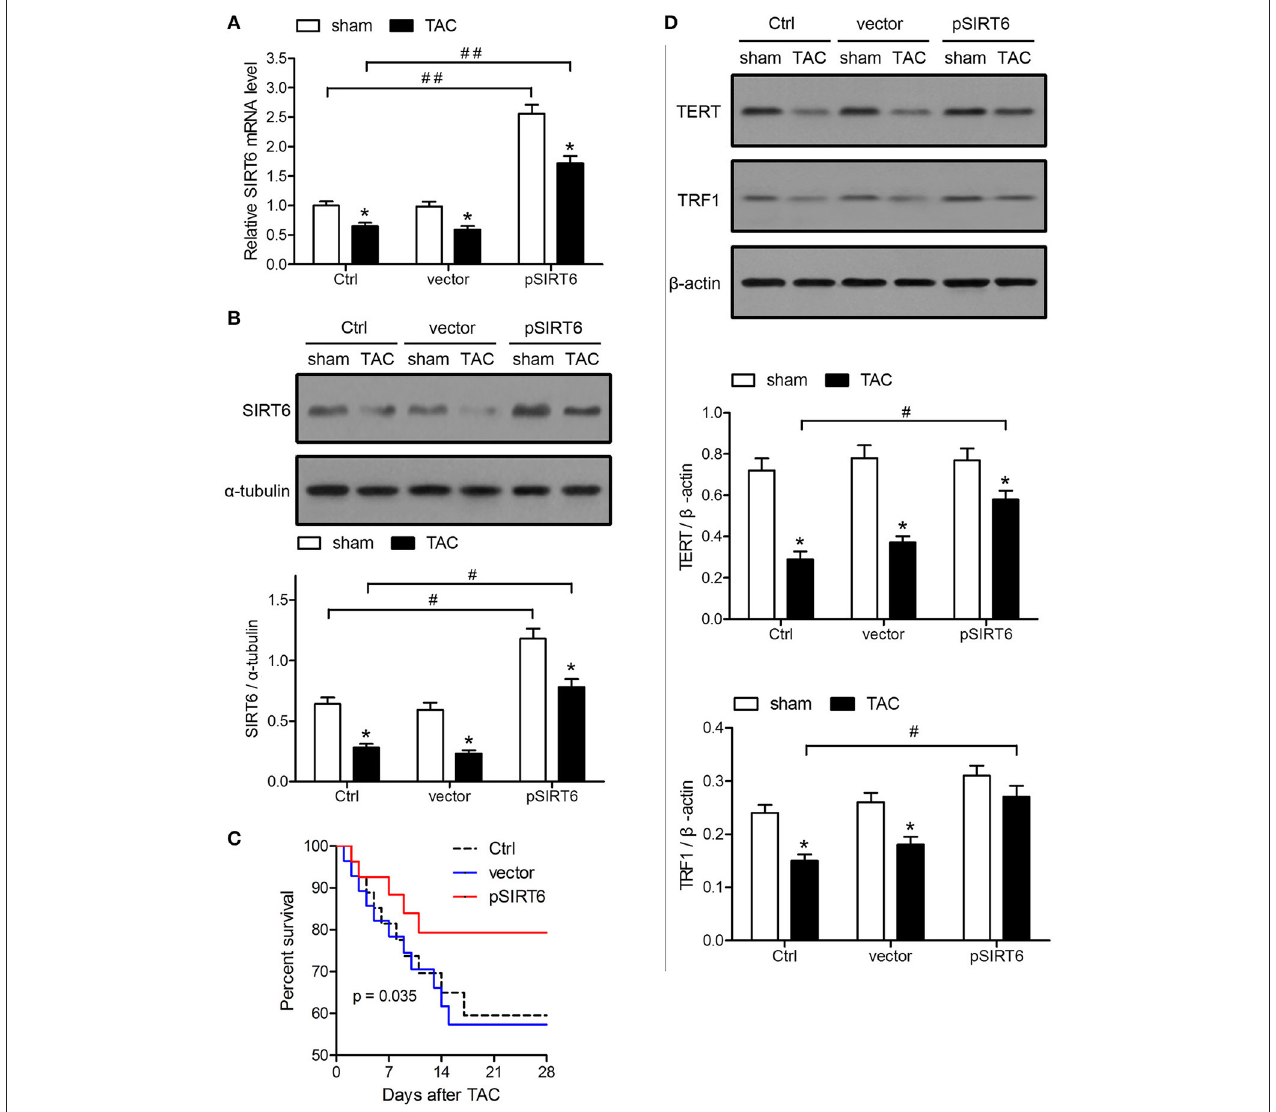
FIGURE 2 | SIRT6 overexpression improves the survival of TAC mice and upregulates TERT and TRF1. Mice were injected intravenously via the tail vein with 100 µ l pLVX-IRES-puro vector (vector) or vector expressing SIRT6 (pSIRT6) lentivirus plasmids at 2 weeks and 24 h before TAC or sham surgery. Myocardial tissue samples were collected at 28 days after surgery. Mice without lentivirus injection served as the control (Ctrl). (A) SIRT6 mRNA expression in myocardial tissues was determined by qRT-PCR and normalized to GAPDH levels. * P < 0.05 vs. sham group, ## P < 0.01. n = 8–10 per group. (B) Protein expression levels of SIRT6 were analyzed by western blotting and normalized to α -tubulin expression levels. * P < 0.05 vs. sham group, # P < 0.05. n = 8–10 per group. (C) Survival analysis of mice treated as indicated each day after TAC. n = 30 per group. (D) Western blot assessment of TERT and TRF1 expression normalized to β -actin levels. * P < 0.05 vs. sham group, # P < 0.05. n = 8 per